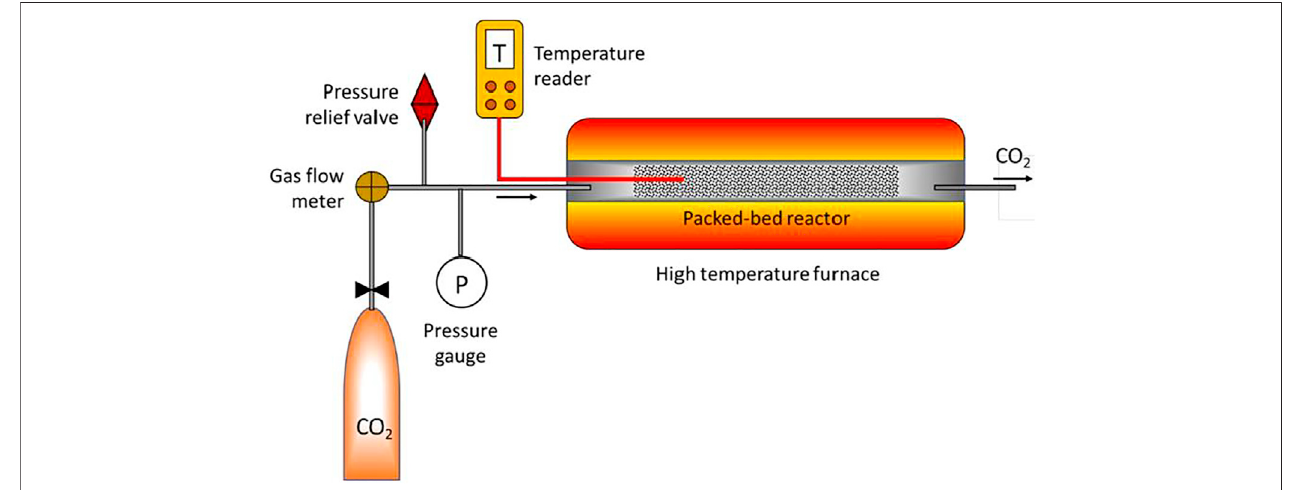
FIGURE 2 | Scheme of physical activation unit, activation occurred at 900 ° C using a sweeping CO 2 fl owrate of 0.5 L/min for holding times of 0.5, 1, 2, or 3 h (adapted from (Singh, 2019)).